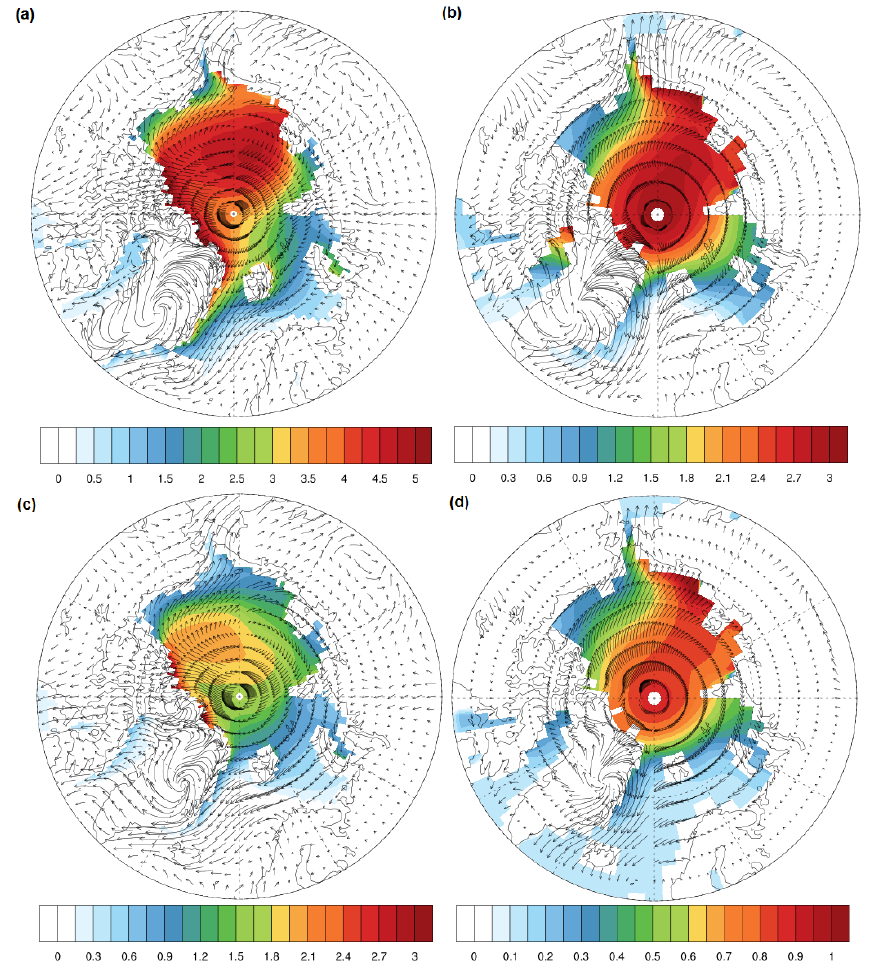
Figure 12. Mean annual 10m winds and sea ice thicknesses (m) for (a) IPSLCM5A pre-industrial, (b) MIROC4m pre-industrial, (c) IP- SLCM5A mid-Pliocene, and (d) MIROC4m mid-Pliocene. Vector length is proportional to wind